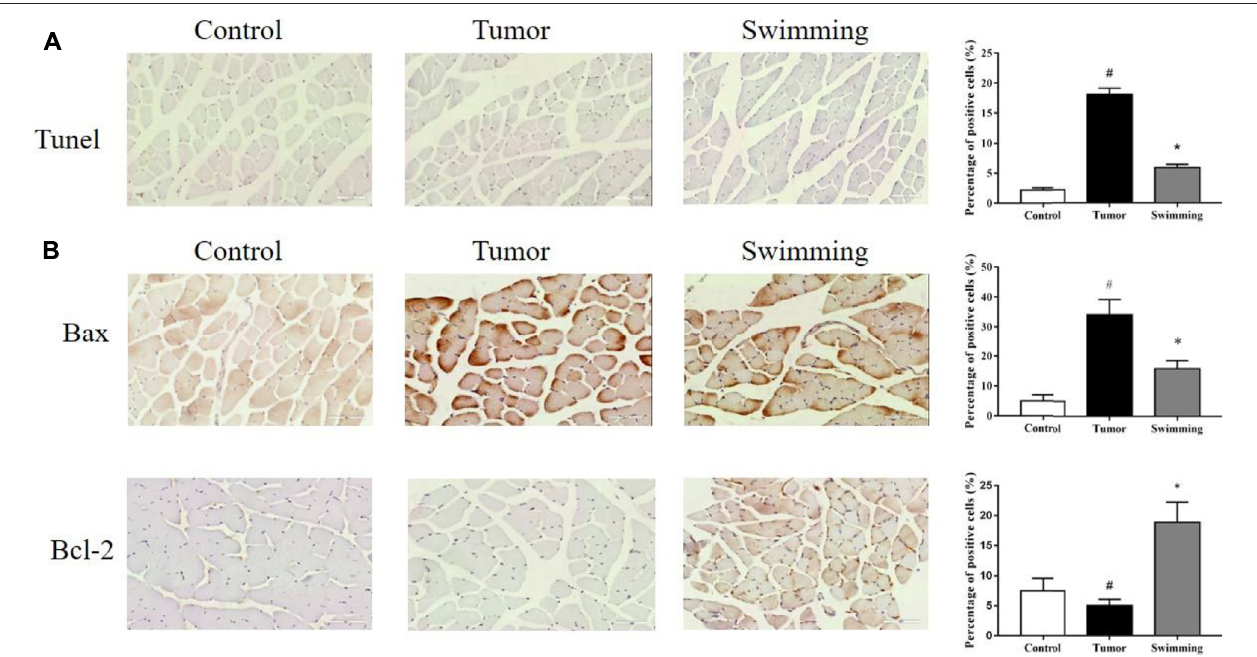
FIGURE 4 | Effects of swimming on cell apoptosis and expression of Bax and Bcl-2 in muscle tissues. (A) TUNEL staining was performed determine the cell apoptosisinmuscletissuesfromeach group.Theimagesweretakenatamagni fi cationof × 400bymicroscopy. Thecellswithbrownnucleuswerede fi nedasapoptotic cells. (B) The protein levels of Bax and Bcl-2 in quadriceps muscle tissues of mice from each group was determined by IHC analysis. The images were taken at a magni fi cation of × 400 by microscopy. The cells with brown staining were de fi ned as positive stained cells. Data were presented as mean ± SD. # p < 0.05 vs . Control group; * p < 0.05 vs . Tumor group.